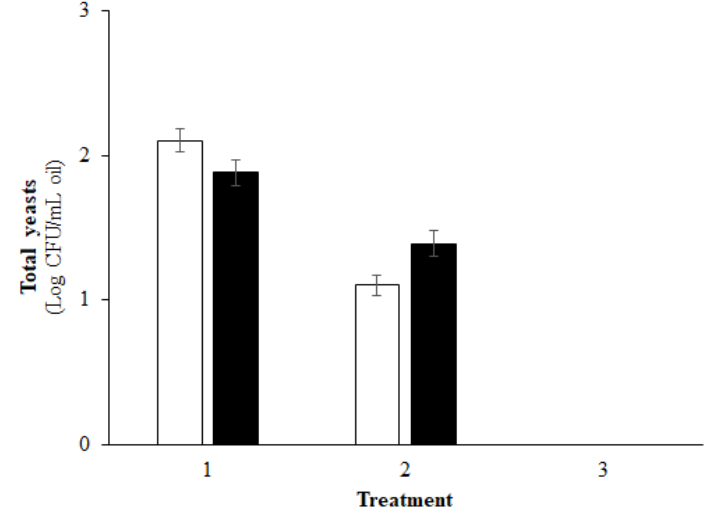
Figure 1. Survival of the yeasts in two monocultivar extra virgin olive oil after one month of storage. (1) Unfiltered extra virgin olive oil; (2) extra virgin olive oil filtered with cotton; (3) extra virgin olive oil filtered with cellulose (total yeasts < detection limits); ( □ ) Coratina cultivar; ( ◼ ) Nera di Colletorto cultivar. The data refers to means ± standard deviation.